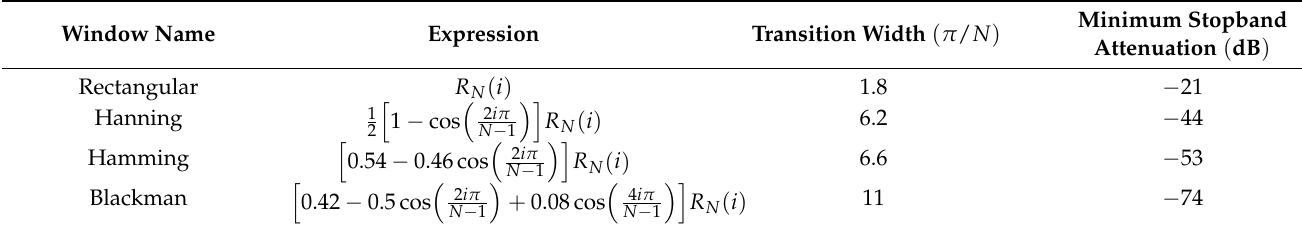
Table A1. Several commonly used window functions in the design of the FIR filter